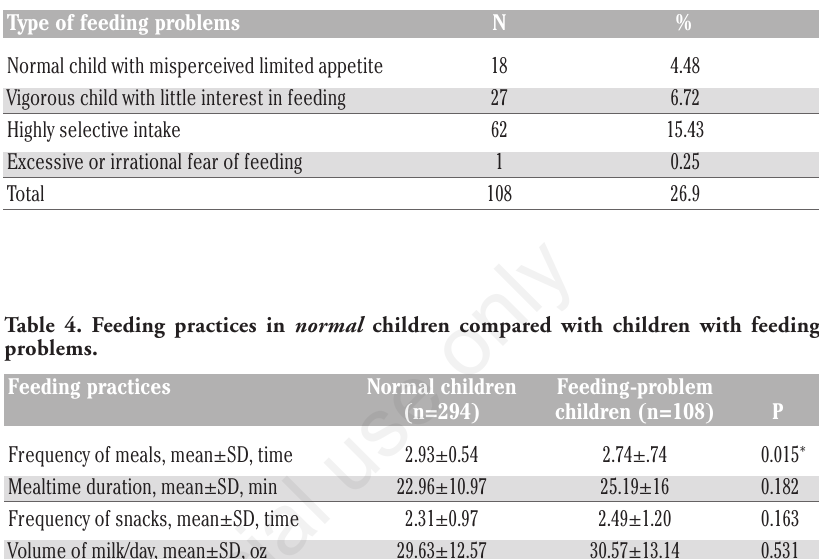
Table 3. Types of feeding problems (n=402).